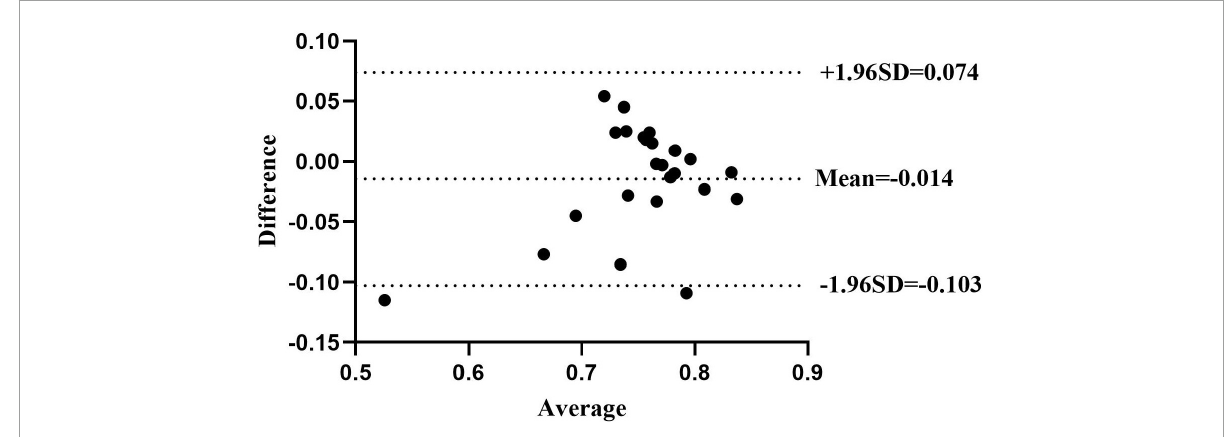
FIGURE5 The Bland-Altman plot shows agreement between the older group’s first and second AIDAW tests. The mean difference score was –0.014, and the 95% limits of agreement were –0.103 and 0.074. All but two points fall within the 95% limits.